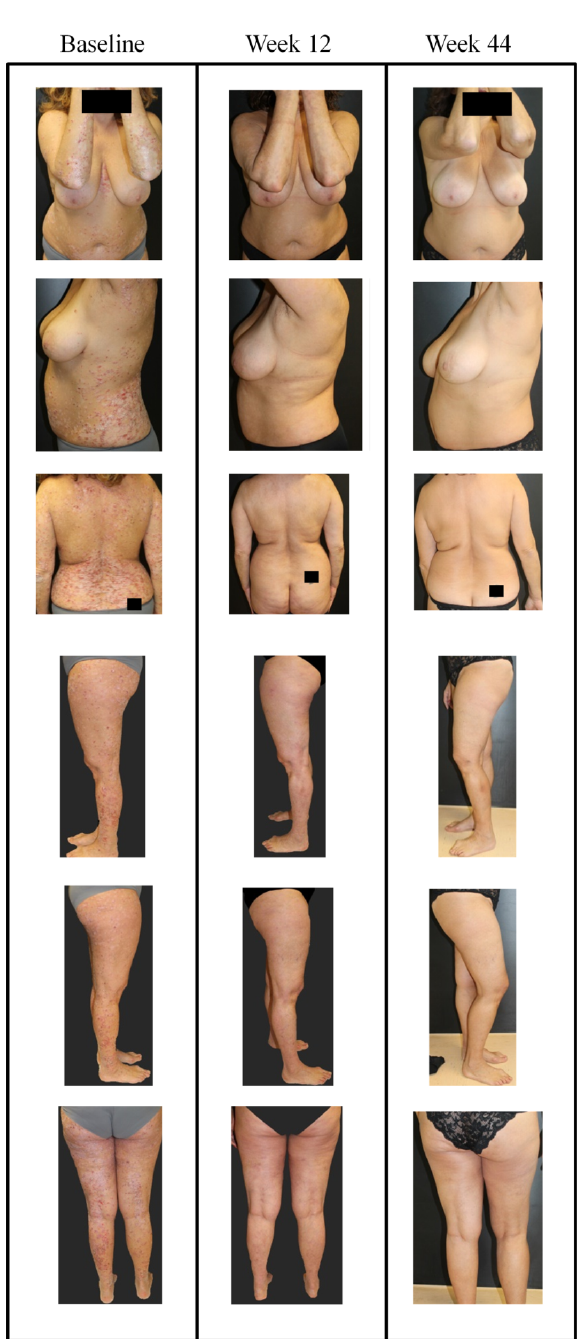
Figure 3. Representative images of outcome in case #1; a female patient, aged 52 years with onset of psoriasis at 47 years of age, cigarette smoker (34 pack years) with dyslipidemia and naïve to biological treatment. In January 2019 she presented with severe psoriasis and arthralgia in the small joints of the hands. Ultrasound examination in this patient identified dactylitis and moderate tenosynovitis associated with weak but positive color Power Doppler signal which corresponded with the proximal and distal phalangeal joints of the second finger of the right hand. Previous therapies included cyclosporine (250 mg / day) from 2014 to December 2018, without interruption, with loss of response in the last 3 months. Biological screening tests did not reveal any noteworthy alterations. Images at di ff erent sites are presented for the time points; baseline, week 16, and week 36. After baseline visit (PASI of 44.4 and visual analogue scale (VAS) pain of 80), guselkumab treatment was initiated (induction phase: 100 mg subcutaneously at weeks 0 and 4, and a maintenance dose every 8 weeks thereafter). After 12 weeks, PASI decreased to 3 and VAS pain was 30; at week 44, PASI decreased further to 0 and pain VAS was